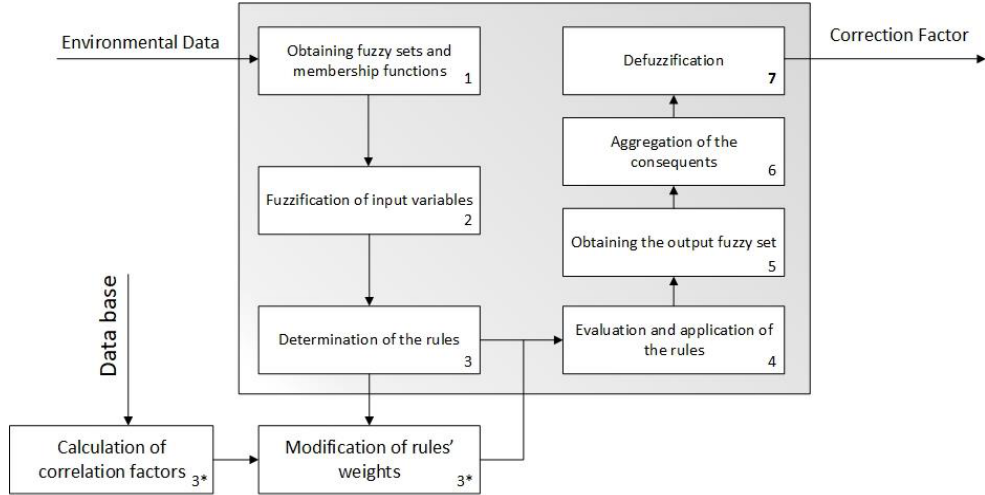
Figure 3. Inference system used for the Correction Factor. The steps where the correlation factor is calculated in order to modify the rules of the inference system are indicated with a *.